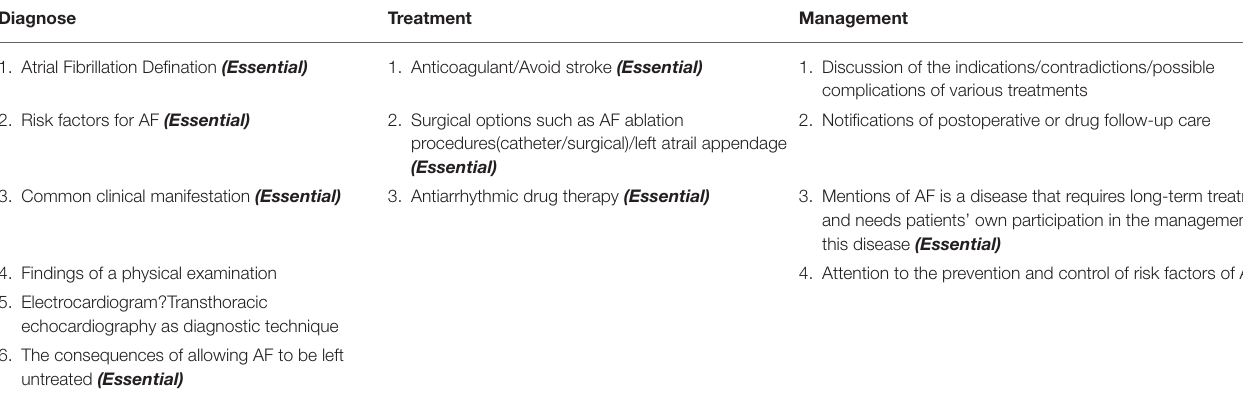
TABLE 3 | Video criteria grouped into parent categories. Diagnose